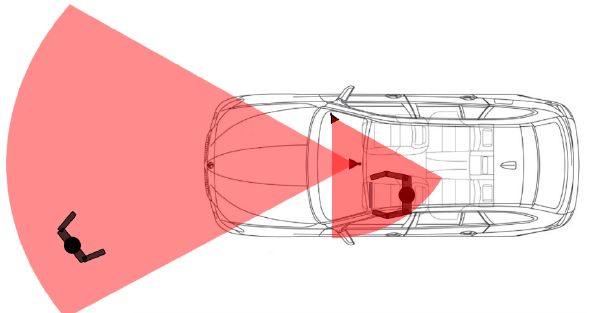
Figure 1: Position and orientation (black triangles) and field of view (red) of a exterior and interior looking vehicle camera used for recording of the scene in front of a vehicle and the driver, respectively. Images can be used to detect pedestrians (black top- down